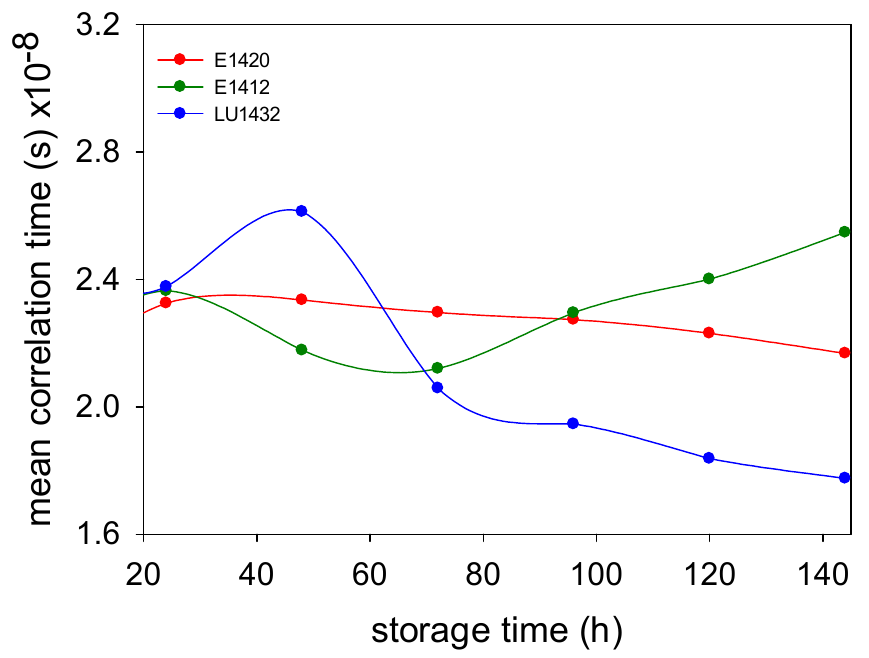
Figure 7. Time-dependent changes in mean values of proton motion correlation times of starch proton fraction in bovine fat emulsions emulsified with potato starches.